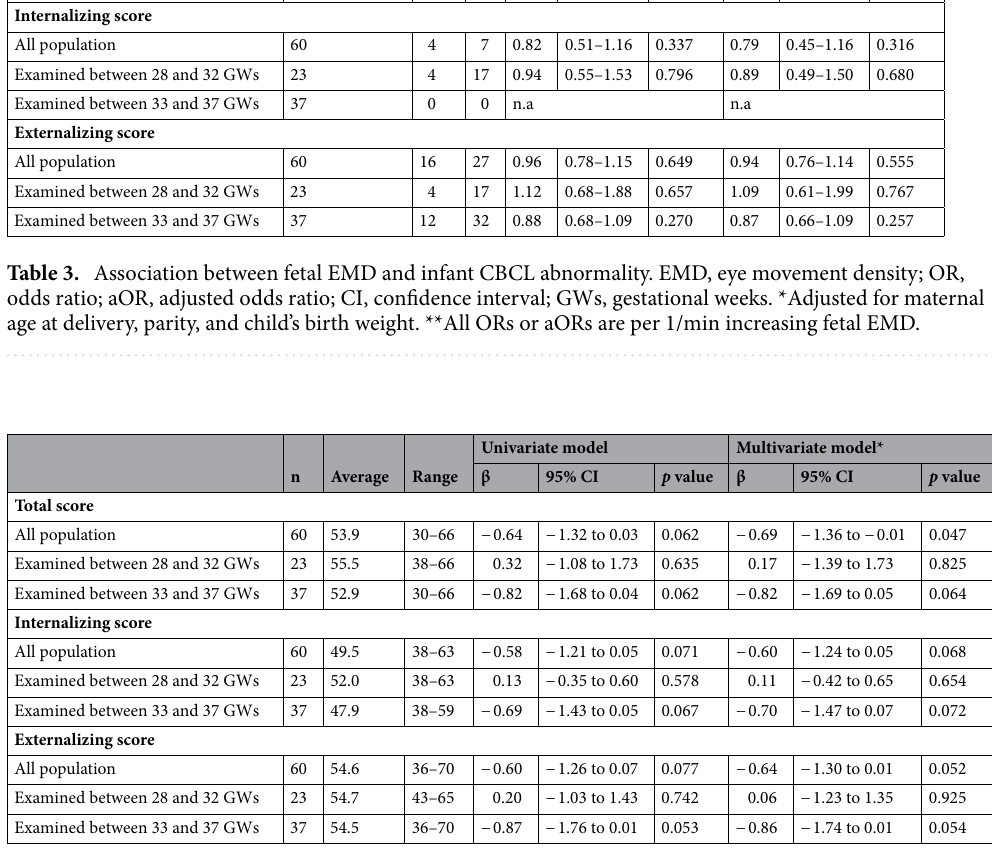
Table 4. Association of fetal EMD and CBCL T-scores. EMD, eye movement density; β, partial regression coefficient; CI, confidence interval; GWs, gestational weeks. *Adjusted for maternal age at delivery, parity, and child’s birth